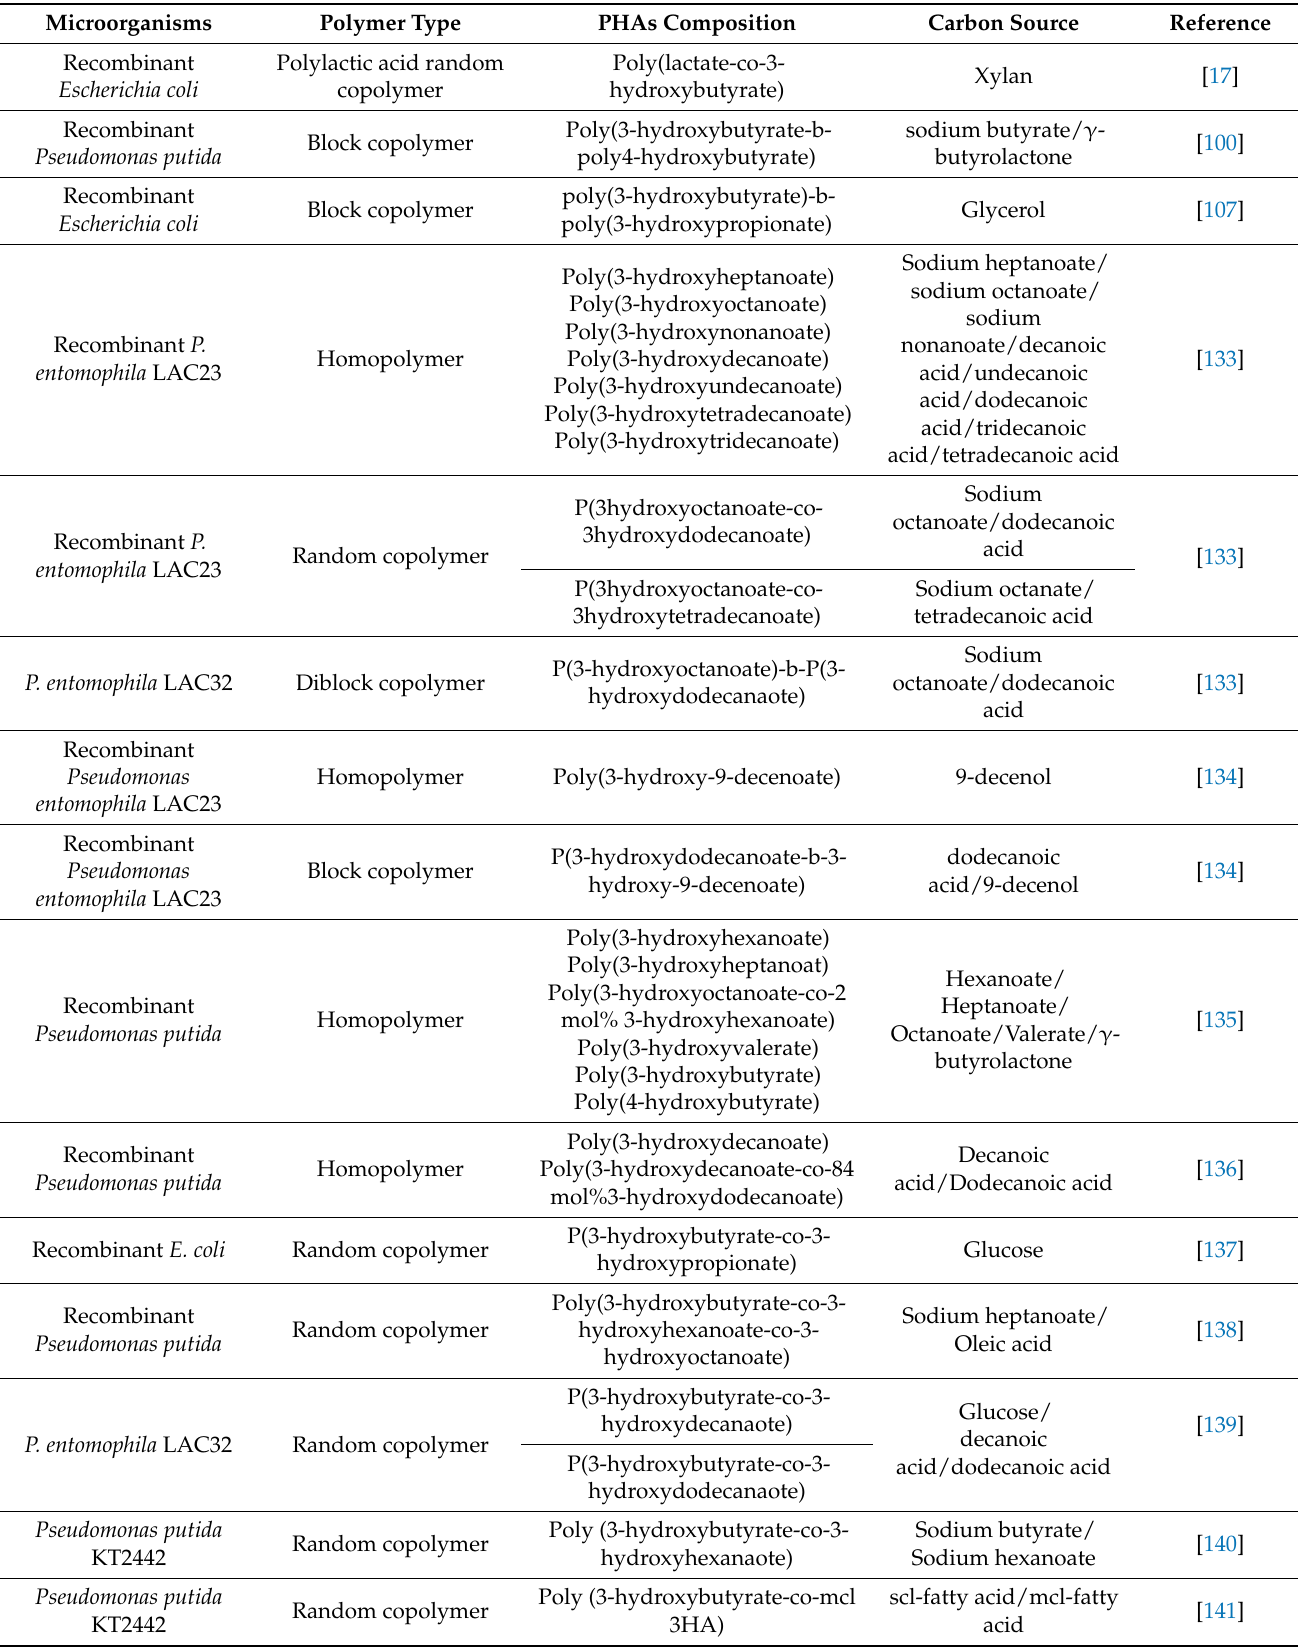
Table 5. Production of different types of PHA polymers by recombinant